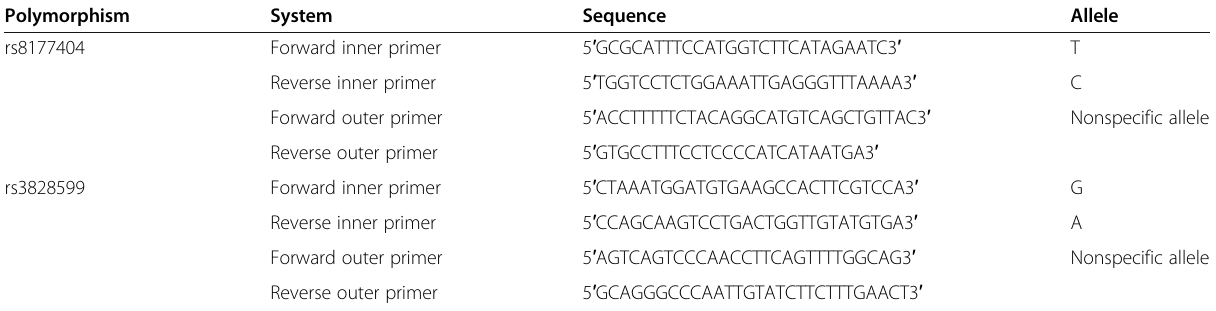
Table 1 The list of primers used for in tetra-primer ARMS-PCR method to detect the genotypes of GPX3 rs8177404 and rs3828599 polymorphisms Polymorphism